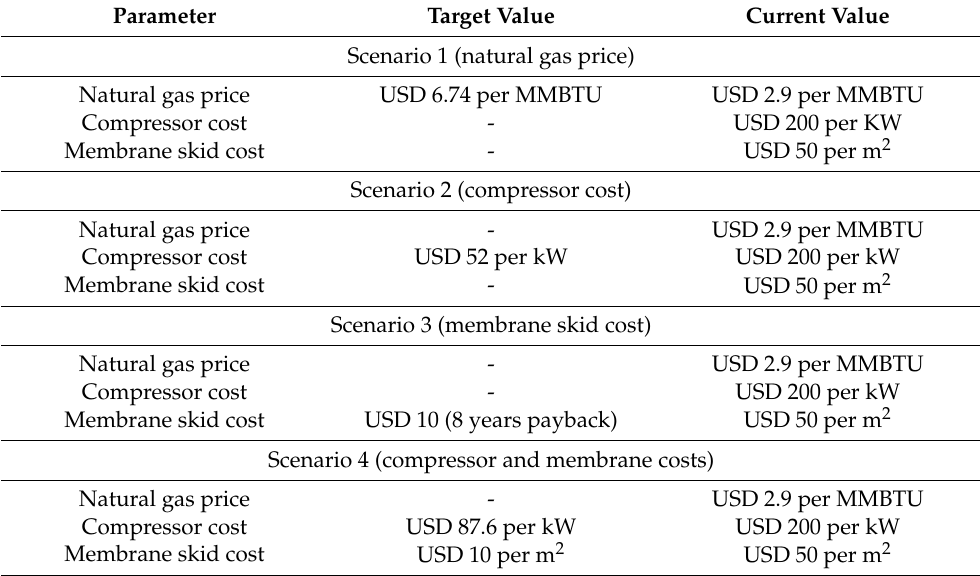
Table 6. Scenarios in which the membrane system could be profitable for oxygen enrichment (30 mol%) at the Alzour power plant for a payback duration of 3